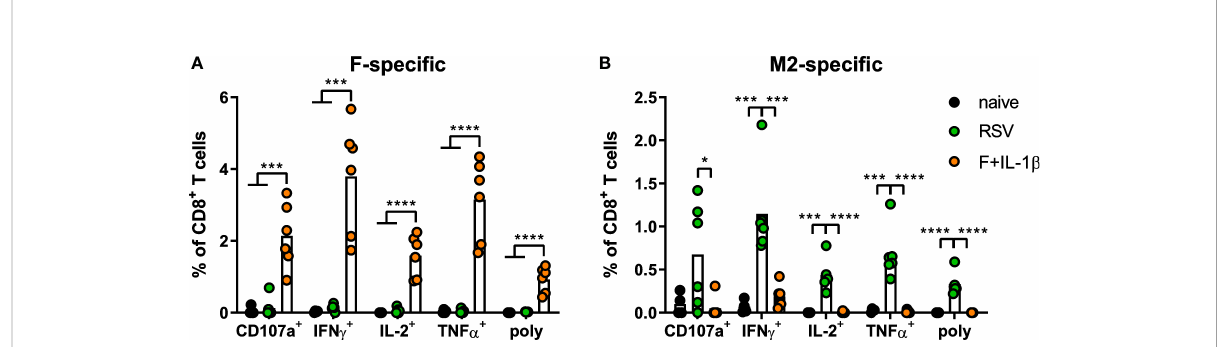
FIGURE 6 Mucosal T cell functionality induced by mucosal vaccination and a primary RSV infection. Lung lymphocytes were restimulated with MHC-class I peptides derived from the F (A) and the M2 protein (B) and the functionality of CD8 + T cells was detected via extracellular staining for CD107a and intracellular cytokine staining (poly; CD107a + IFN g + IL-2 + TNF a + ; gating strategy in Supplementary Figure 3). Bars represent group means overlaid with individual data points. n=4-6. Data were analyzed by one-way ANOVA followed by Tukey´s post Test. * p <0.05, ** p <0.005, *** p <0.0005, **** p